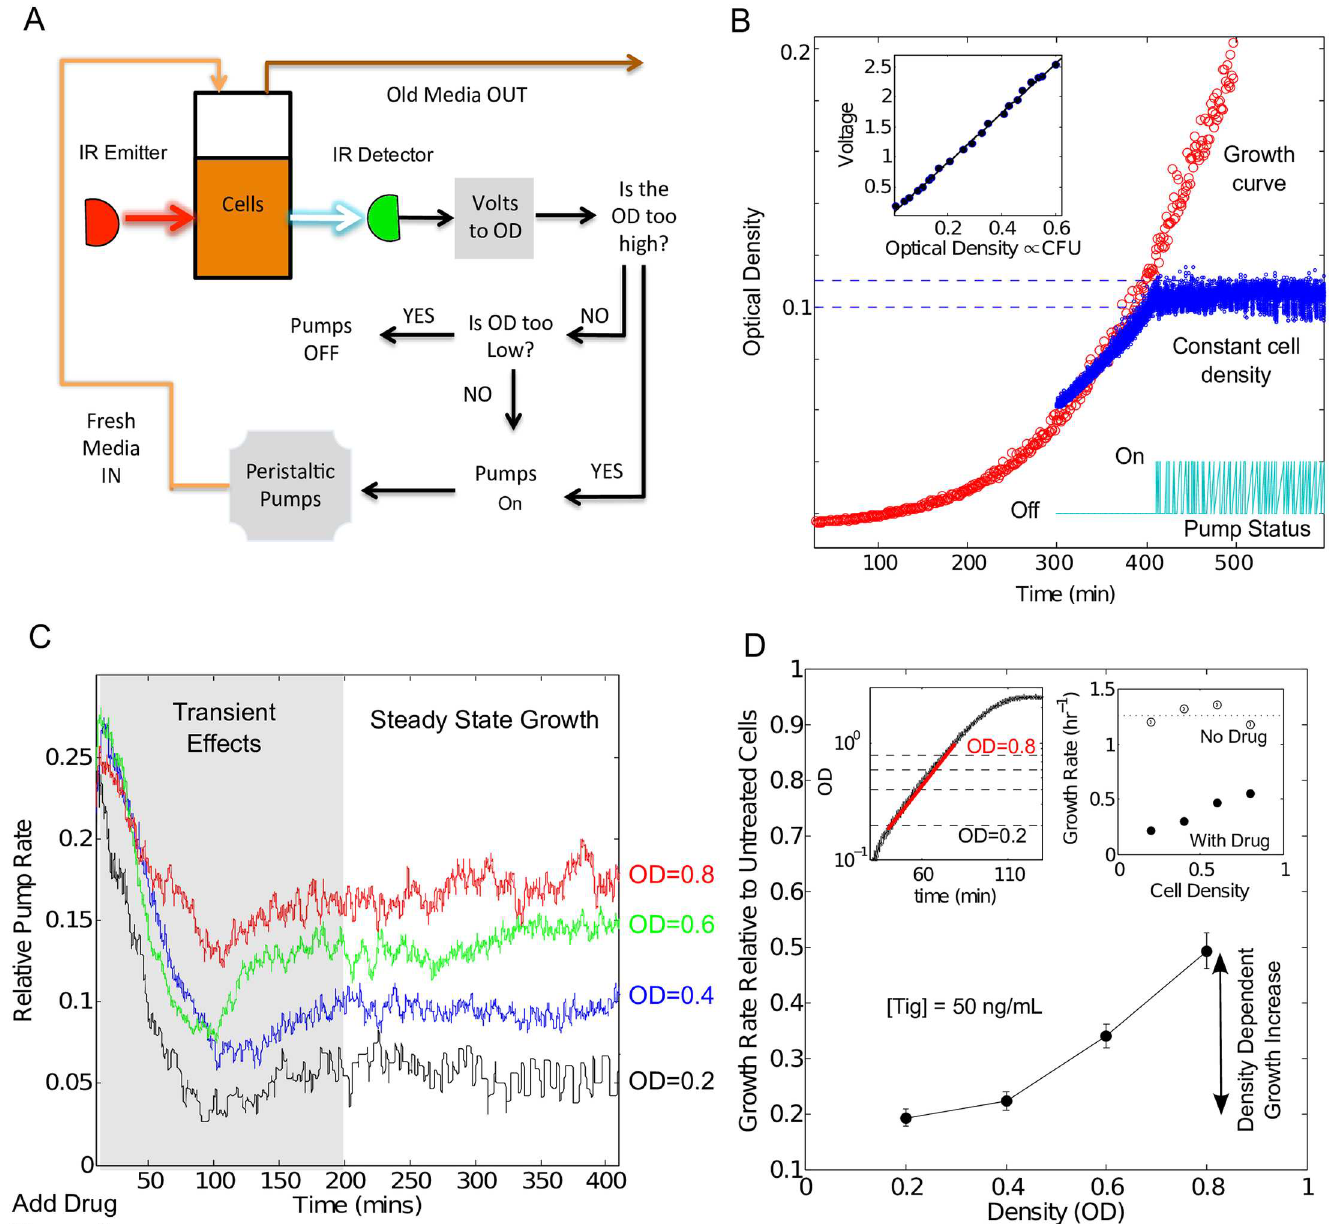
Fig 1. Computer-controlled continuous culture devices can measure population growth at constant cell density. A. Bacterial cultures (15 mL) are grown in glass vials with customizedTeflon tops that allow inflow and outflow of fluid via silicone tubing. Cell density is monitored by light scattering using infrared LED/Detector pairs on the side of each vial holder. At the onset of the experiment, stationary phase bacterial cultures are diluted 500X and allowedto grow in the culture vials until a specific density is reached. At that point, drug is manuallyadded at the desired concentration to both the culture vial and a connected chamber with fresh media. Flow between the media chamber, the culture vial, and a waste vial is managedby a series of computer- controlledperistaltic pumps that maintain constant cell density accordingto the pictured schematic. The entire system is controlledby custom Matlab software, and up to 18 cultures can be grown simultaneously using a multi-position magnetic stirrer. See also Figure A in S1 Text. B. Examples of a bacterial growth curve (red) and a constant cell-density experiment in which feedback from light scattering is used to maintain a constant cell density (blue). Lower inset: time series showingthe status of the inflow/outflow pump, which provides fresh media and removed waste, during constant density (blue) experiment. Because total culture volume remains constant, the pump status time series can be used to calculate per capita growth rate, g, as a function of time when cell density is held constant: g = F/V, where F is the (time dependent) pump flow rate (mL/min) and V is the (constant) culture volume (mL). Upper inset: Calibration plot showingthat voltage output from IR detectors is linearlyrelated to optical density. C. Time dependent population growth rate is estimated from the relative pump flow rate F(t), which is the flow rate of the pumps requiredto maintain cell density (flow rates